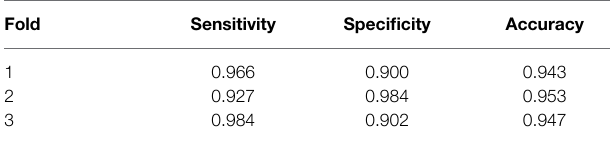
TABLE 1 | Classification results a